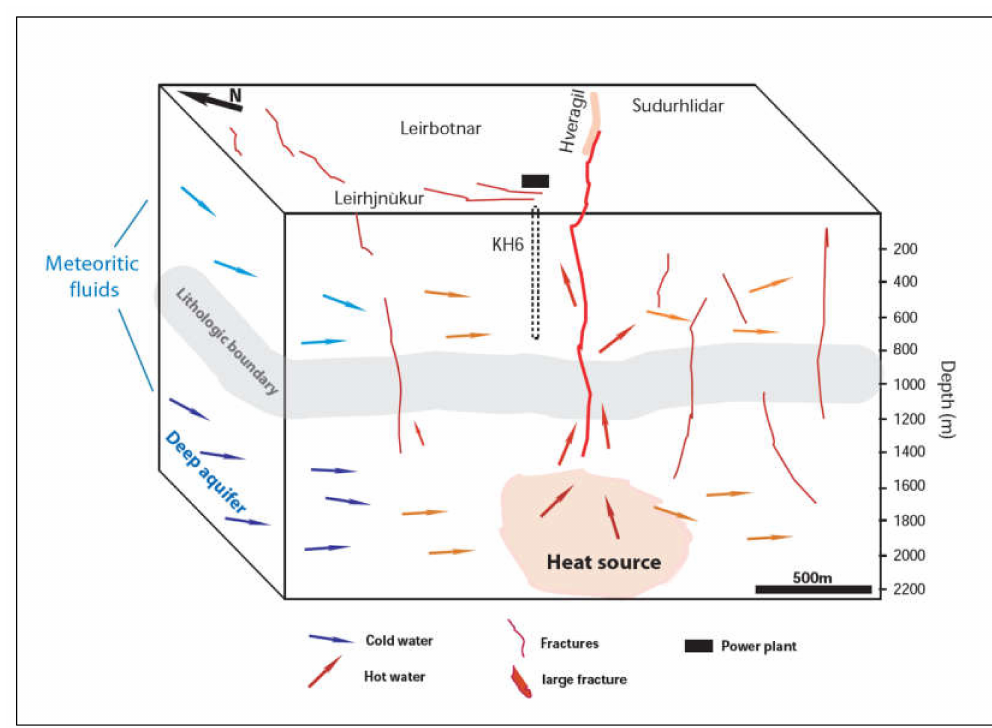
Figure 3. Updated model of hydrogeology in the Krafla geothermal system (modified after